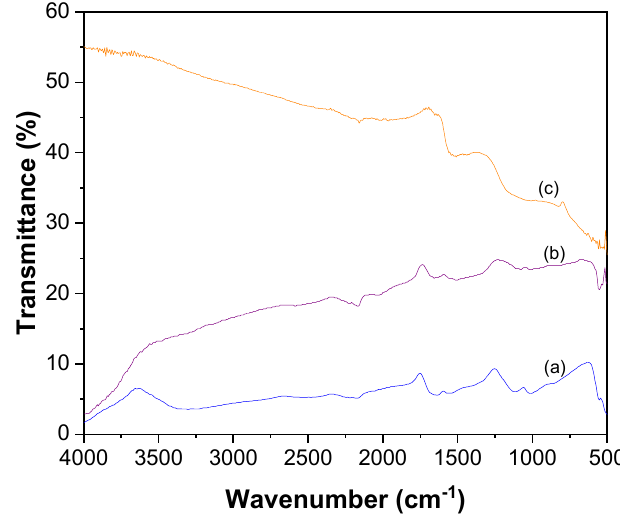
Figure 1. ATR ‐ FTIR spectra of ( a ) CNTs ‐ COOH, ( b ) Ag 2 S, and ( c ) CNTs ‐ Ag 2 S. Figure 1. ATR-FTIR spectra of ( a ) CNTs-COOH, ( b ) Ag 2 S, and ( c ) CNTs-Ag 2